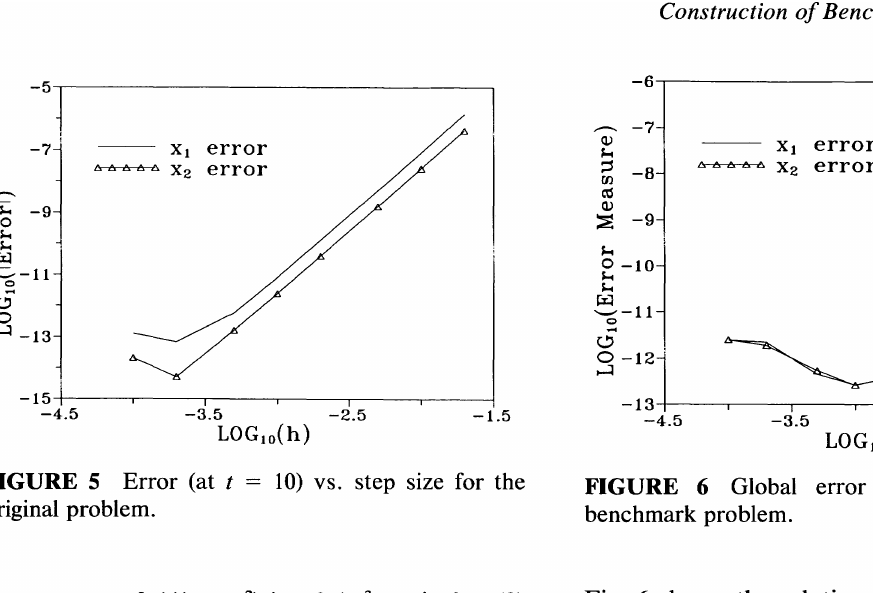
FIGURE 5 Error (at t = 10) vs. step size for the original problem.